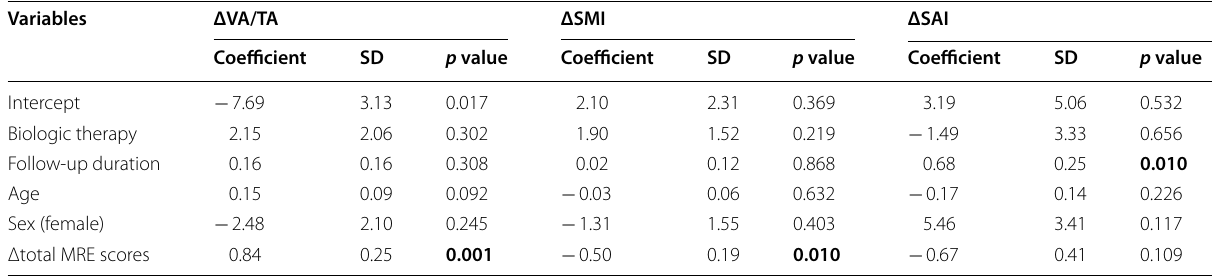
p values below 0.05 are marked in bold MRE Magnetic resonance enterography, SMI skeletal muscle index, SAI subcutaneous adipose tissue index, VA/TA area of visceral fat/area of subcutaneous fat